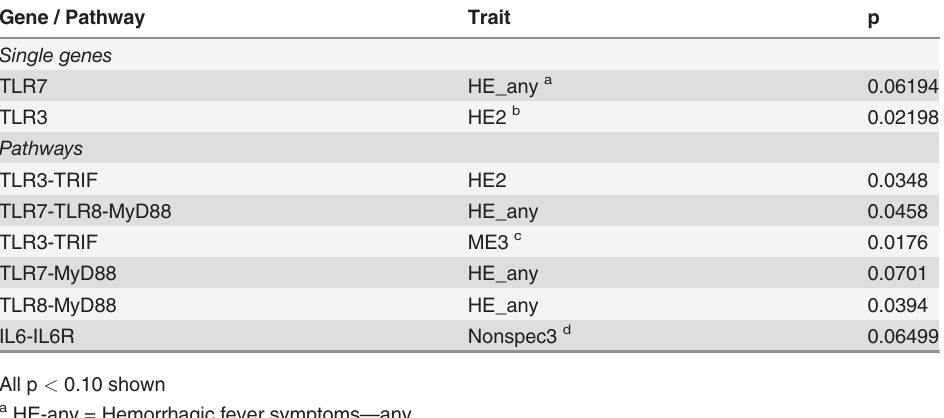
Table 5. Gene and pathway — level associations.